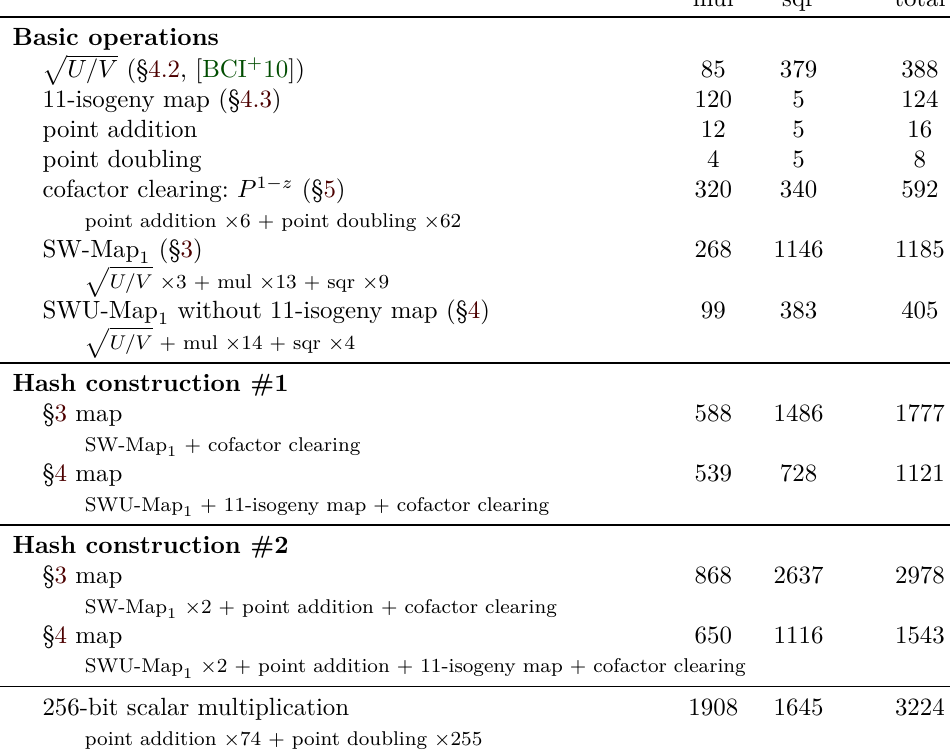
Table 2: Costs for constant-time hash constructions #1 and #2 to G 1 (Table 1). mul is one multiplication in F p ; sqr is one squaring. The rightmost column estimates the total cost assuming that a sqr costs 80% of a